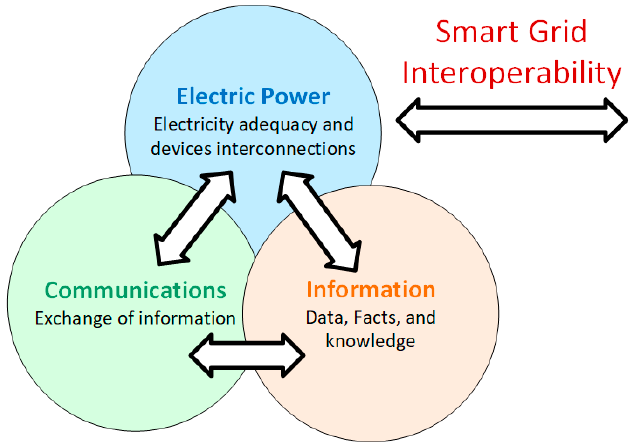
Figure 6. Smart grid interoperability: the integration of power, communications, and information technologies [68].